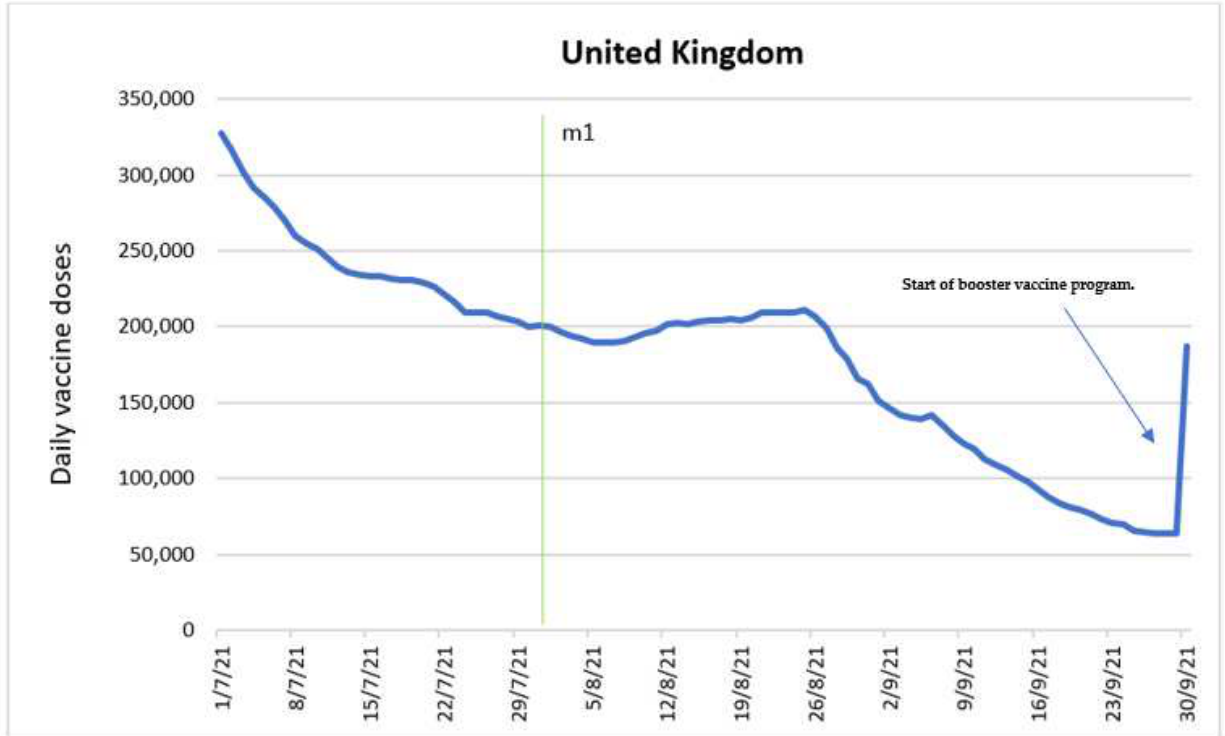
Figure 8. Daily new vaccinations in the United Kingdom before and after the introduction of discounts and vouchers for the vaccinated.